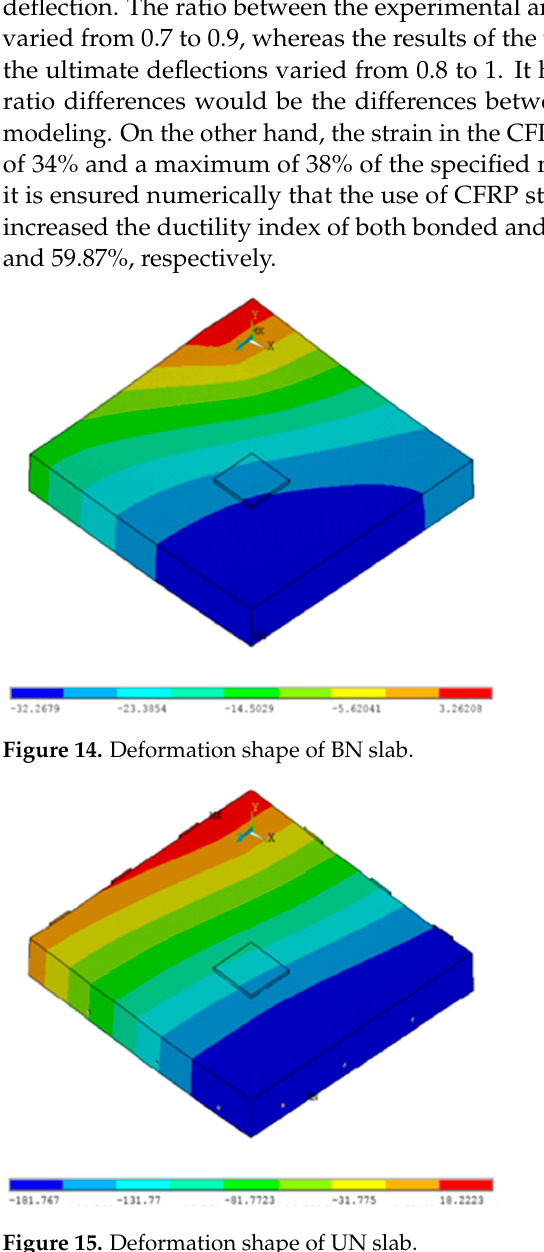
Figure 16. Deformation shape of BS1 slab. Figure 17. Deformation shape of BS2 slab.